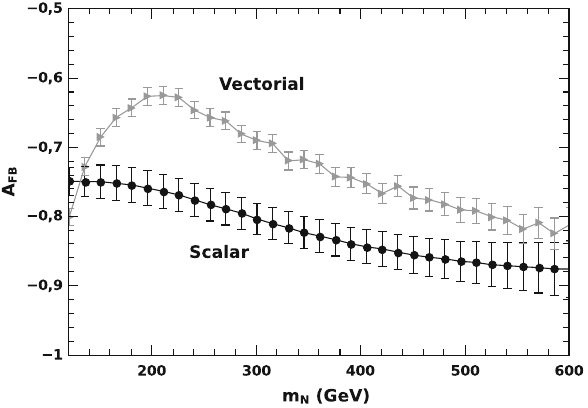
Fig. 8 Cross section dependence with P e for the vectorial and scalar operators 5 Initial electron